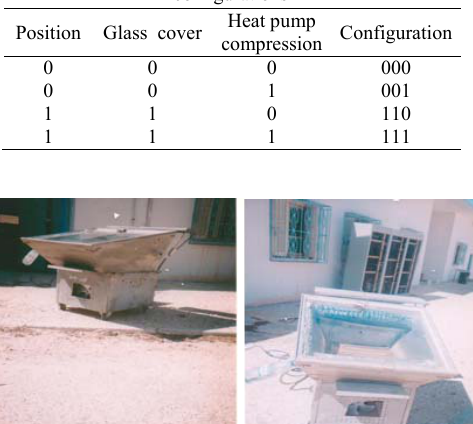
Table 2 Operating parameters for different studied configurations